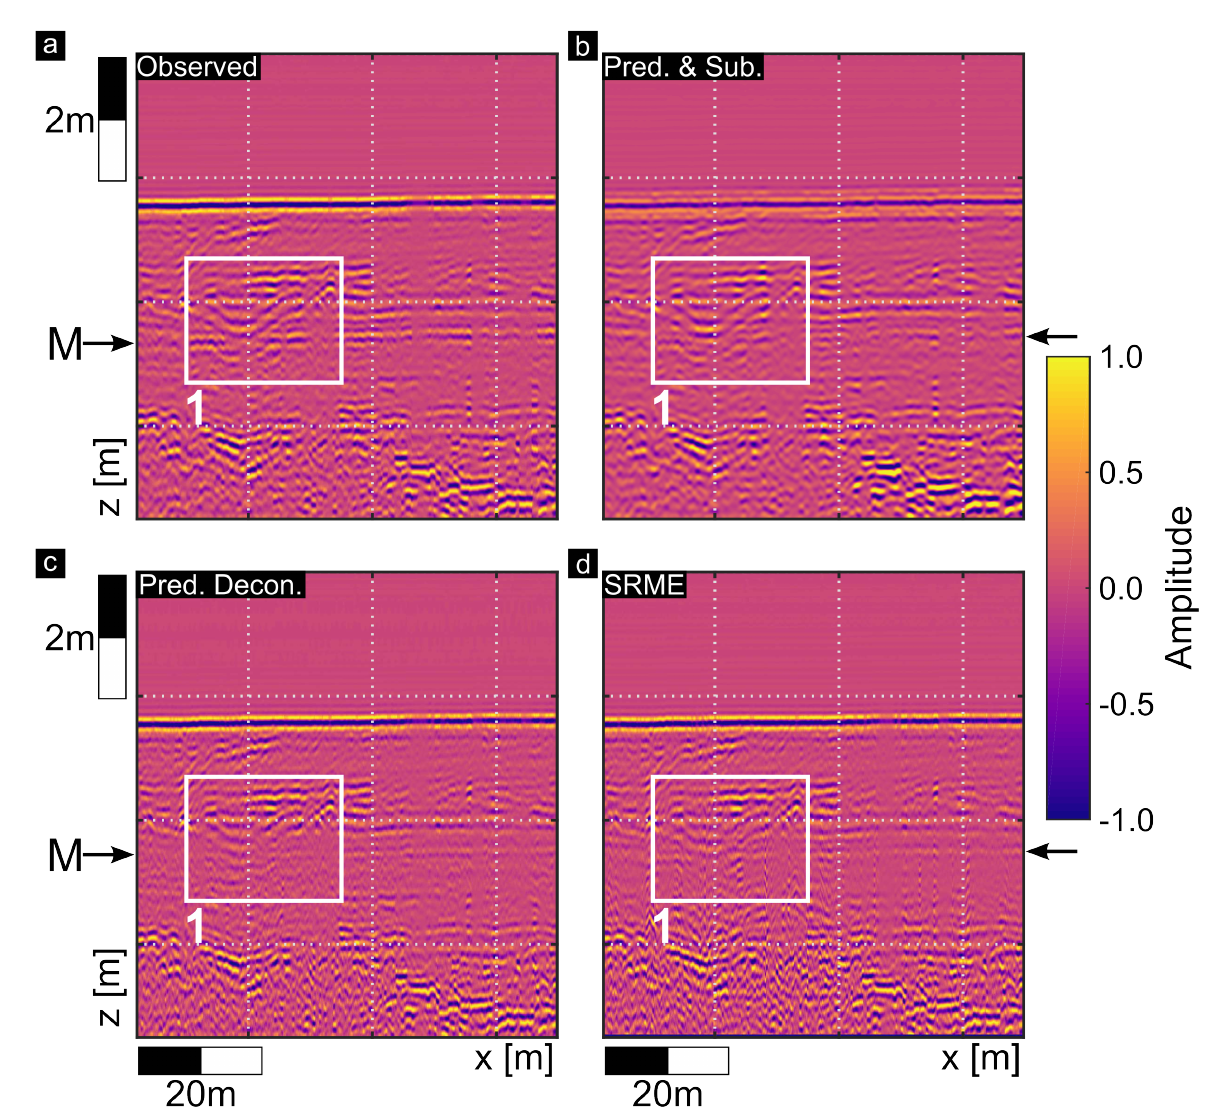
Figure 12. Results of the application of the multiple attenuation methods to field data set 2, ( a ) constant-offset section acquired in the German North Sea. The observed data is shown in panel a and the results of the Prediction and Subtraction approach is shown in panel ( b ). For comparison the results of the multiple attenuation with Predictive Deconvolution ( c ) and SRME ( d ) are shown. The (attenuated) first water bottom multiple is marked by an arrow. The white box (1) marks details shown in Figure